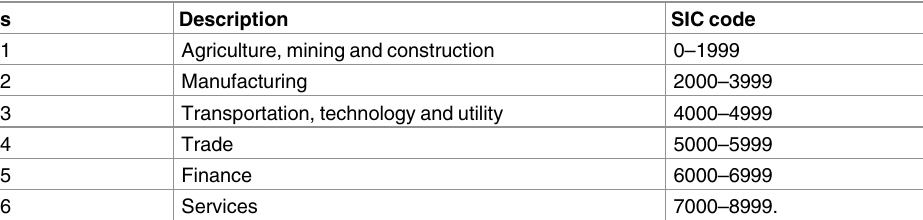
Table 4. Industry sectorsand their SIC